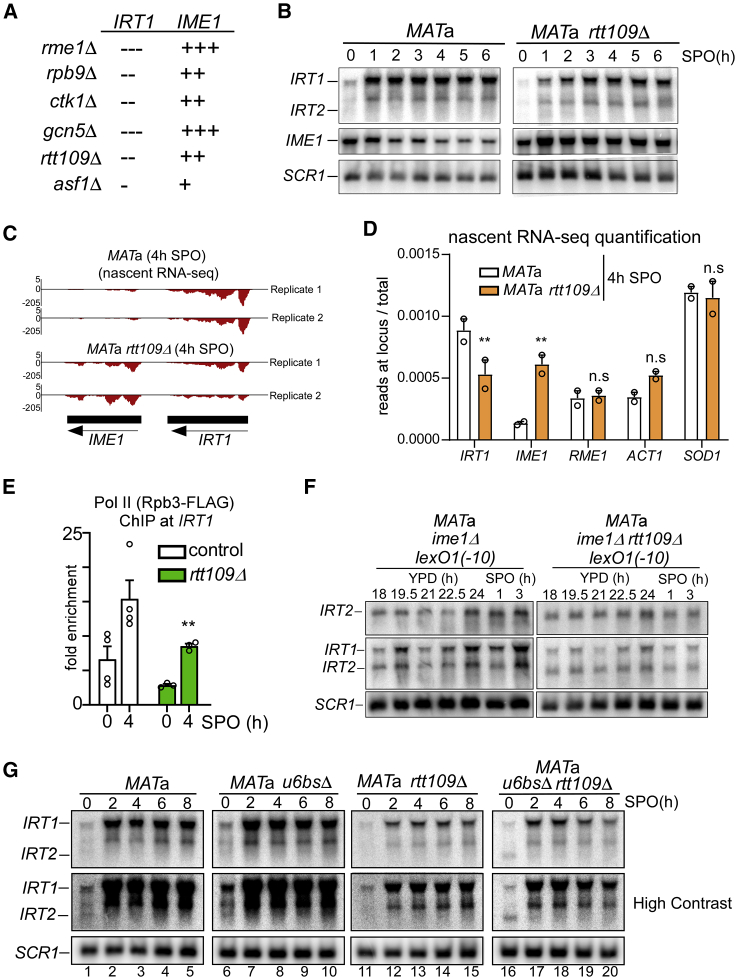
Rtt109 mediates IRT2-directed activation of IRT1 transcription(A) Candidate genes involved in IRT2-mediated activation of IRT1. The minus symbol represents lower IRT1 expression compared to MATa WT cells, and the plus symbol represents higher IME1 expression compared to MATa WT cells.(B) IRT1, IRT2, and IME1 expression in WT MATa (FW1509) and rtt109Δ (FW4077) cells detected by northern blot.(C) Nascent RNA-seq (Pol II-associated RNA) for the IRT1 and IME1 loci from MATa control (FW4031) and rtt109Δ (FW4075) cells harvested 4 h in SPO. Two replicates are presented. Pol II was purified using the Rpb3-FLAG. The y axes indicate reads per million (RPM).(D) Nascent RNA-seq read quantifications of selected transcripts (IRT1, IME1, and the controls RME1, ACT1, and SOD1) as obtained in (C). Error bars represent ±SEM; n = 2. ∗∗p < 0.005, parametric unpaired two-tailed Student’s t test.(E) Pol II ChIP with IRT1 in control MATa and rtt109Δ cells (FW8515 and FW8561). Error bars represent SEM; n ≥ 3. ∗∗p < 0.005, two-way ANOVA followed by a Fisher’s LSD test performed on the whole group of samples, including those presented in Figure 2D.(F) IRT1 and IRT2 expression in MATa ime1Δ cells with a lexO1(−10) site at IRT2 (FW7142) and in the same cells including a rtt109Δ mutation (FW8555). Cells were grown in YPD (24 h) and shifted to SPO.(G) IRT1 and IRT2 expression in control MATa (FW1509), u6bsΔ (FW2438), rtt109Δ (FW4077), and u6bsΔ rtt109Δ double-mutant (FW5225) cells.